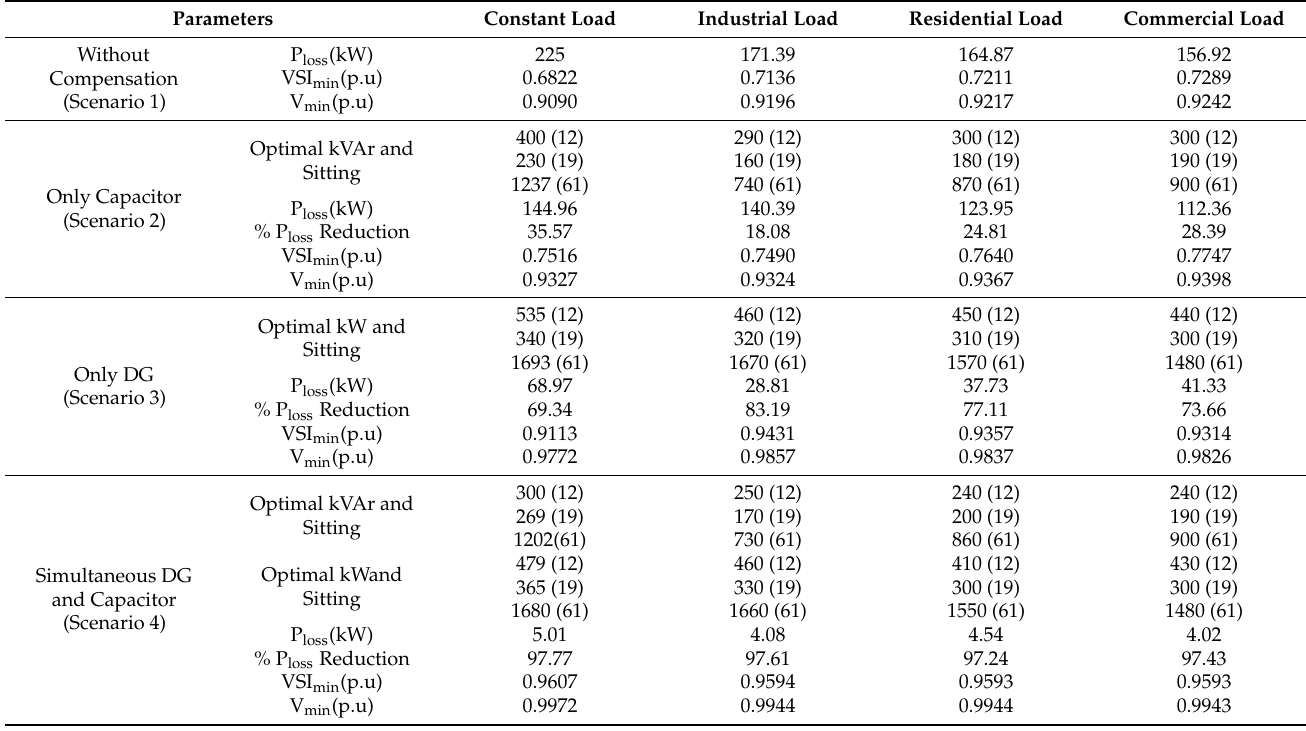
Table 5. Results of IEEE 69-RDS (various load